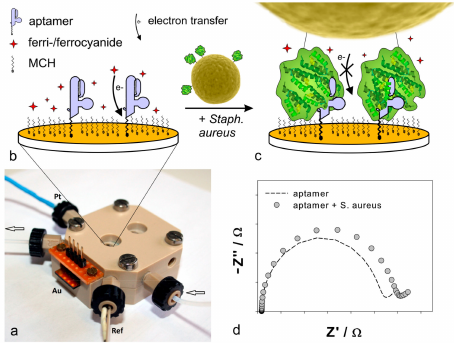
Figure 1. Flow-through measurement chamber and measurement principle. ( a ) Flow-through measurement chamber with liquid inlet and outlet (arrows) and a 3-electrode setup including a golden working electrode (Au), a platinum counter electrode (Pt) and a reference electrode (Ref); ( b ) Working electrode modified with aptamer (violet) and 6-mercapto-1-hexanol (MCH) in a buffer containing the redox probe ferri-/ferrocyanide (red stars); ( c ) Upon binding of protein A (green) on the surface of S. aureus (yellow) to the immobilized aptamer (violet), the impedance increased due to the hindrance of electron transfer (curved arrow) between ferri-/ferrocyanide (red stars) in solution and gold electrode surface (orange); ( d ) Characteristic Nyquist-plot of impedance spectra before and after incubation with S. aureus (based on data from measurements); Z’: real part of impedance and Z”: imaginary part of